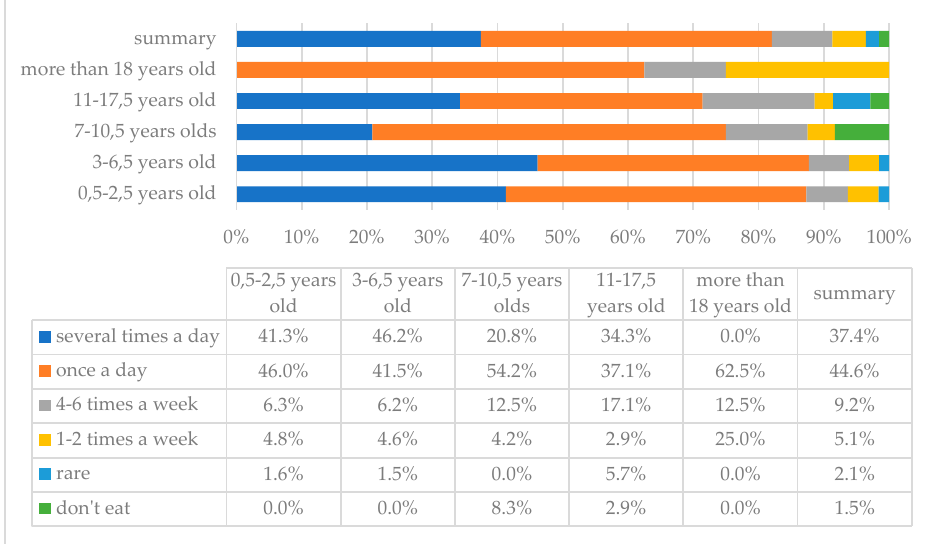
Figure 2. Frequency of fruits intake in the study group of individuals with DS by age.